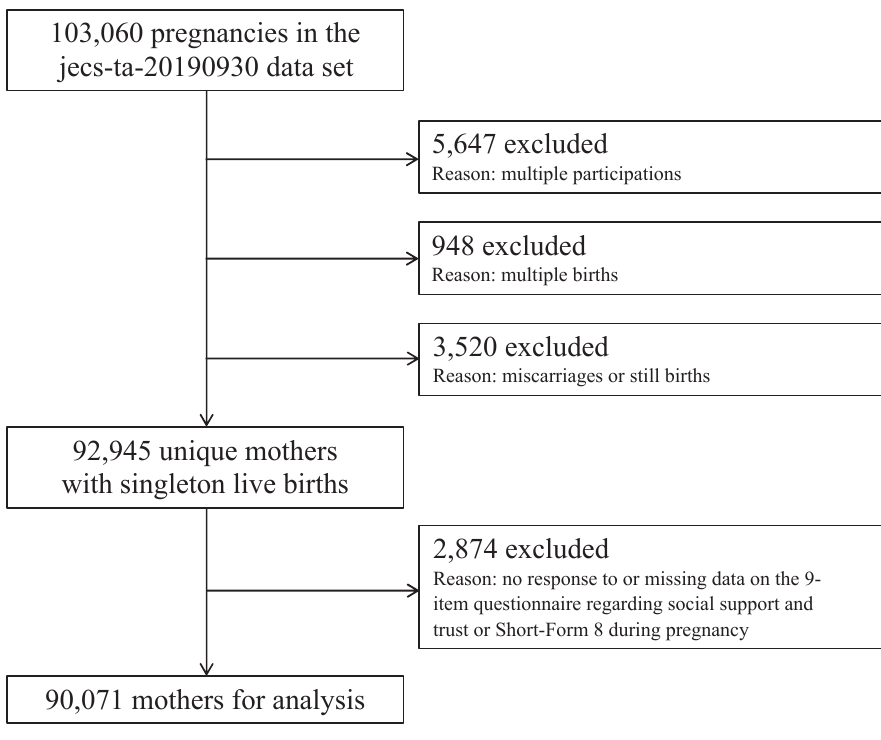
Figure 1. Participant fl ow